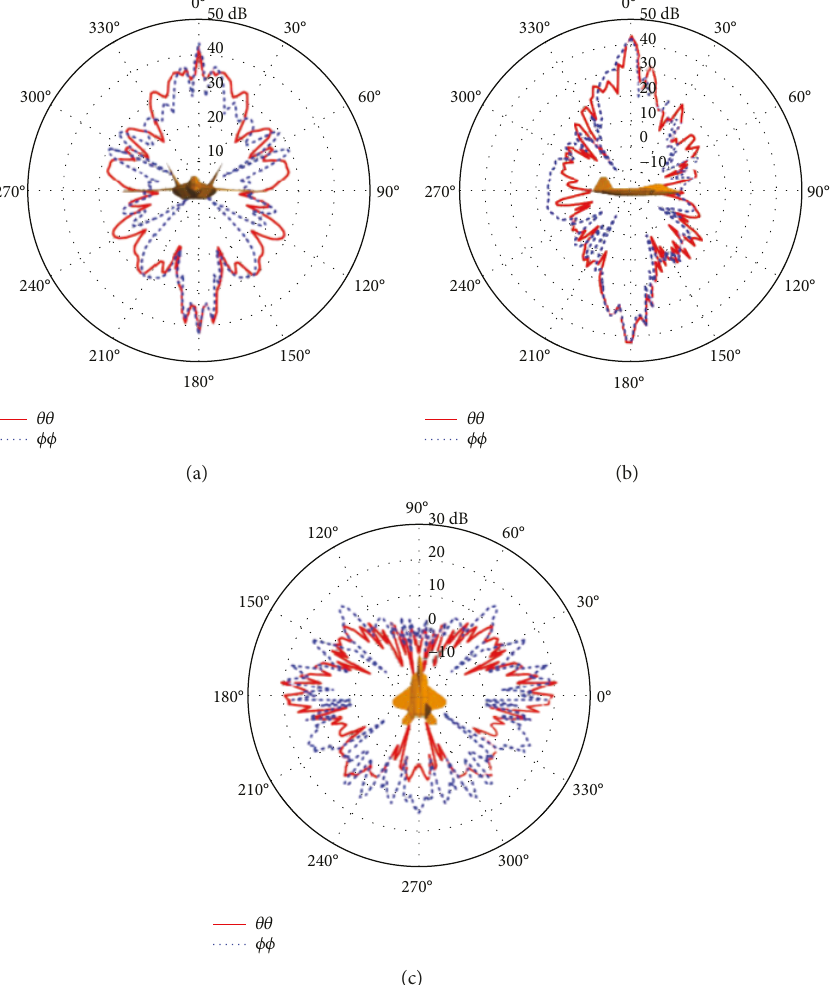
Figure 3: Monostatic RCS of an aircraft for copolarization. (a) xz plane. (b) yz plane. (c) xy